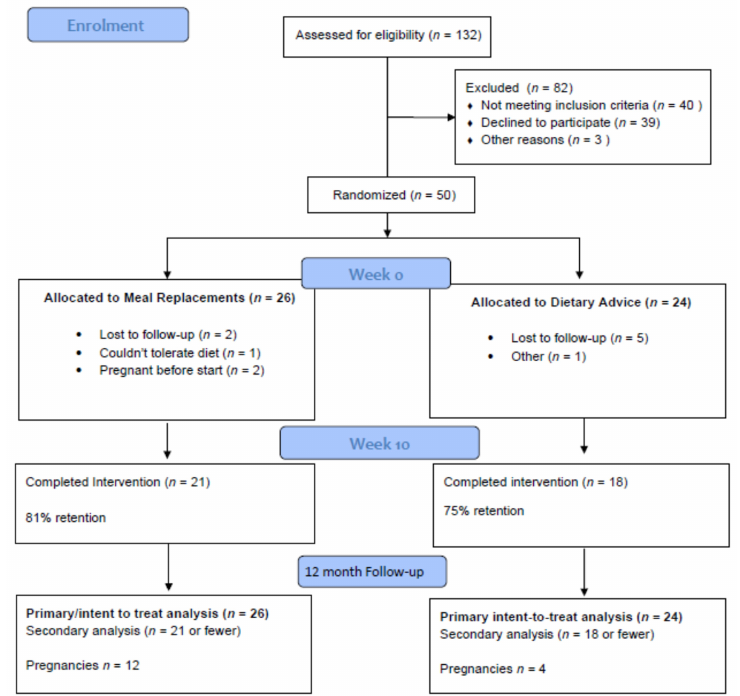
Figure 2. Flow of participants through the study. Table 2. Baseline participant characteristics in the two intervention groups.